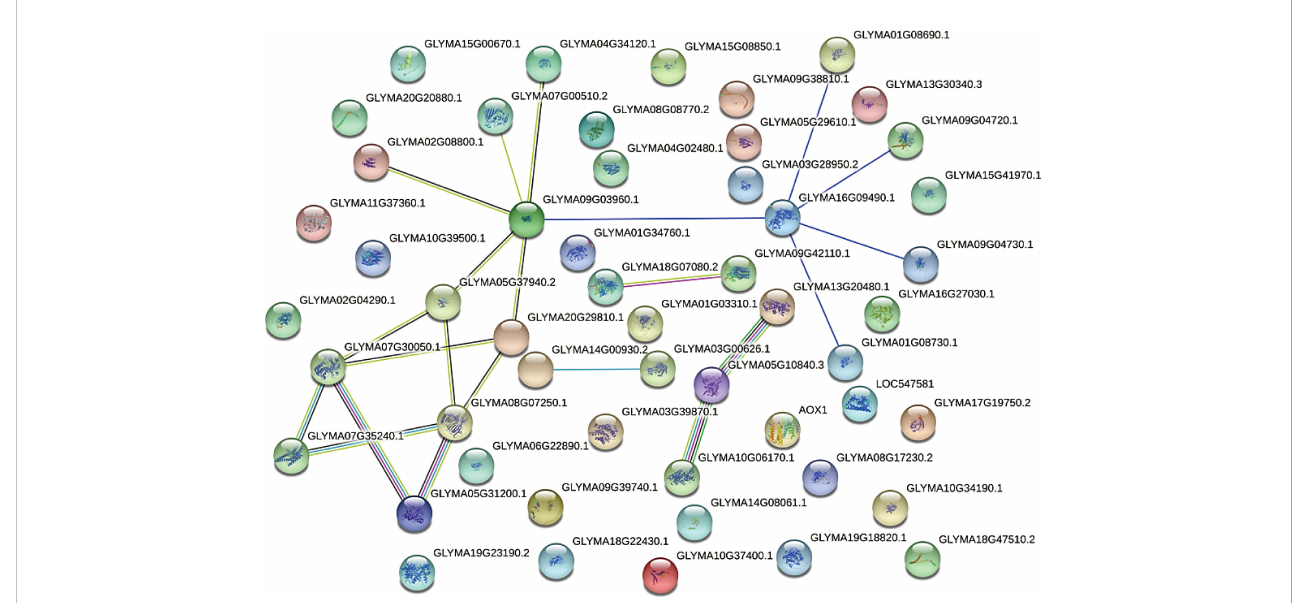
FIGURE 6 Predicted interaction network for 53 proteins that may be involved in cytoplasmic male sterility. Line color indicates the type of interaction evidence. Bright blue, known interaction (curated database); pink, known interaction (experimentally determined); green, predicted interaction (gene neighborhood); red, predicted interaction (gene fusion); dark blue, predicted interaction (gene co-occurrence); green, potential interaction (text mining); black, potential interaction (co-expression); light blue, potential interaction (protein